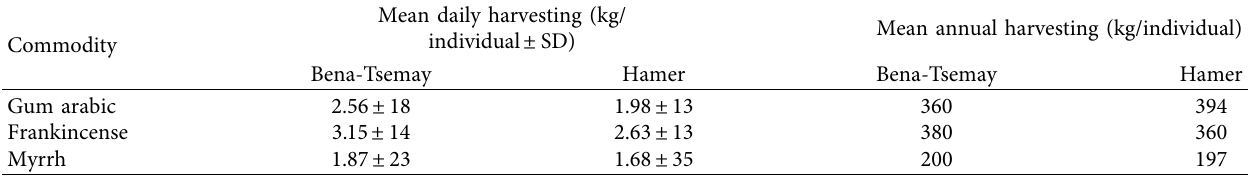
Figure 3: Naturally oozing gum-resin collection and marketing system in in South Omo woodlands. Source: survey data (field photo by Alemayehu, 2018/19). Table 5: Mean daily and annual harvesting of gum-resin products (in kg) in South Omo Zone woodlands.